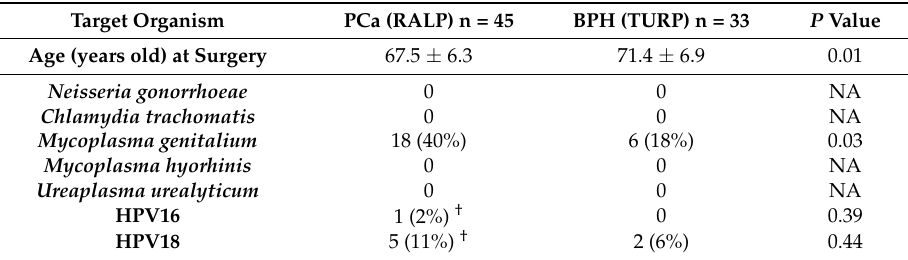
Table 2. Infectious organisms in prostate surgical specimens.